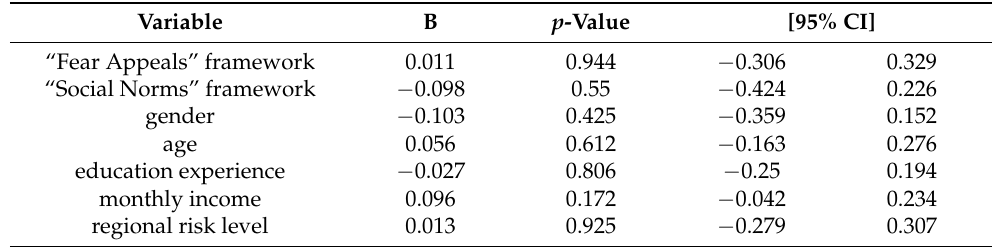
Table A5. Linear regression model of perceived efficacy on risk communication frameworks, n = 165.